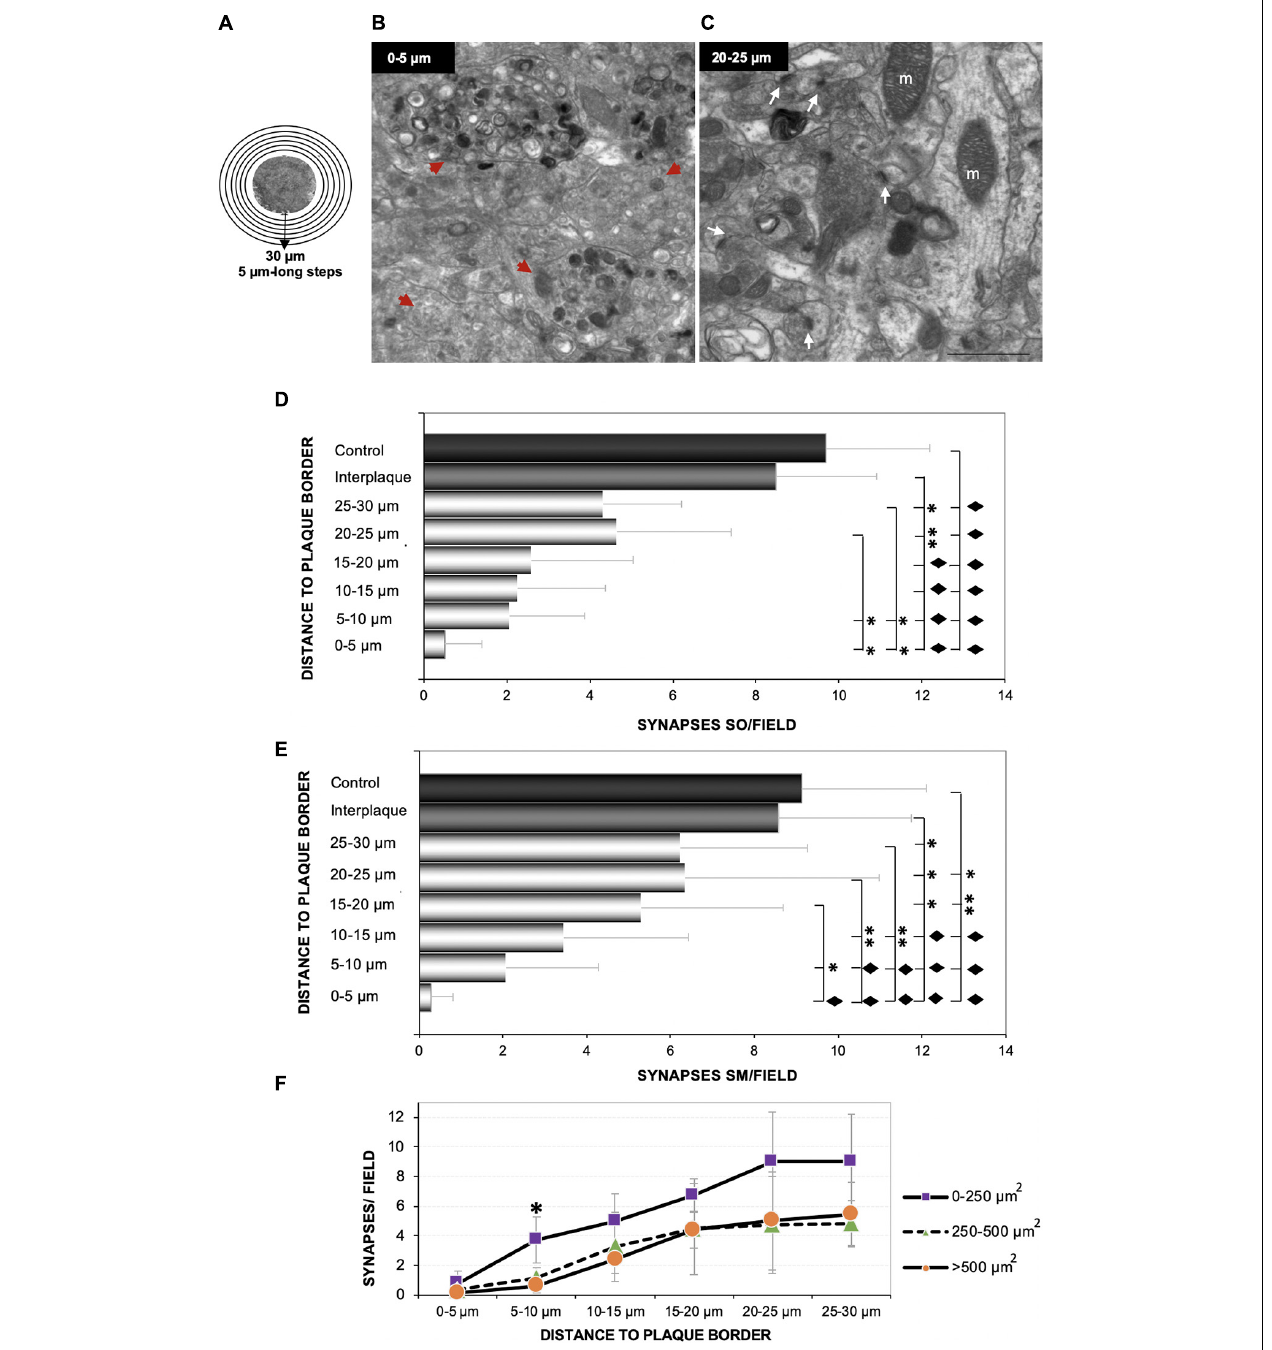
FIGURE 4 | The loss of synaptic contacts increases at closer distance to A β plaques. Six consecutive TEM images were taken from several 30- µ m-long radii, considering the plaque borders as starting points as shown in panel (A) , from 4.5-month-old APP/PS1. Ultramicrophotographs showing the null/scarce number of synapses in areas close to the plaque border [ (B) 0–5 µ m beyond plaque perimeter] compared to further areas [ (C) 20–25 µ m, white arrows] in the stratum moleculare. Moreover, the closer to the plaques, the higher number of dystrophic neurites [red arrowheads in panel (B) ]. The quantification showed a significant decrease in the amount of synaptic contacts close to the plaque, in comparison to both interplaque spaces either in APP/PS1 mice or age-matched control mice ( n = 3/group). Synaptic loss inversely correlated with the distance to A β plaque in each analyzed layer [ (D) stratum oriens; (E) stratum moleculare]. One-way ANOVA F ( 7 , 21 ) = 35.98; p < 0.001, and F ( 7 , 21 ) = 40.81; p < 0.001, respectively. Tukey’s (cid:7) p < 0.001; ∗∗ p < 0.01; ∗ p < 0.05. (F) Finally, we found a relationship between the plaque size and the magnitude of its impact on the nearby synapses [one-way ANOVA F ( 14 , 45 ) = 16.38; p < 0.001, ∗ Tukey’s p = 0.027]. m, mitochondria. Scale bars, (B–C) 1 µ